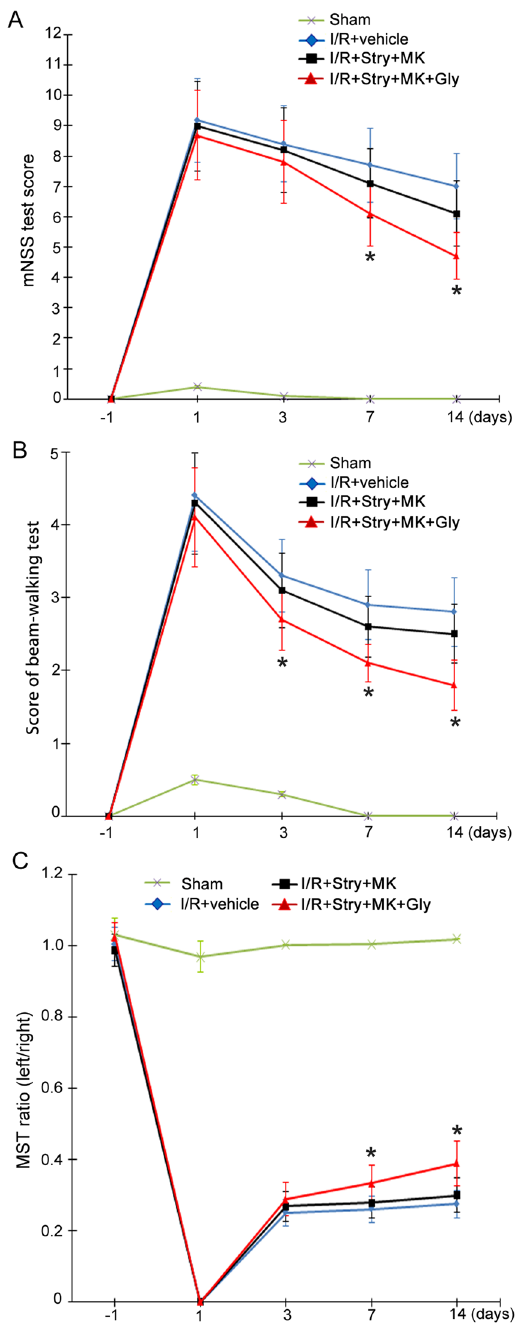
Figure 5. Glycine promotes functional recovery of ischemic stroke animals independent of glycine receptor activation and the channel activity of NMDARs. For all the three experiments, Glycine (100 µ g/100 g, icv) was administered at 3 h following I/R. At 30 min prior to glycine injection, MK-801 (8.0 µ g/100 g, icv) and strychnine (1.2 µ g/100 g, icv) were injected. ( A ) Animals treated with glycine have lower scores of mNSS test at day 7 and 14 after I/R compared with I/R + Stry + MK group (n = 10; ANOVA test, * P < 0.05 vs. I/R + Stry + MK). ( B ) Animals treated with glycine has lower scores of beam-walking test at day 3, 7 and 14 after I/R compared with I/R + Stry + MK group (n = 10; ANOVA test, * P < 0.05 vs. I/R + Stry + MK). ( C ) Animals treated with glycine has higher ratio in MST test at day 7 and 14 after I/R compared with I/R + Stry + MK group (n = 10; ANOVA test, * P < 0.05 vs. I/R + Stry + MK). Stry: Strychnine; MK: MK-801; Gly: